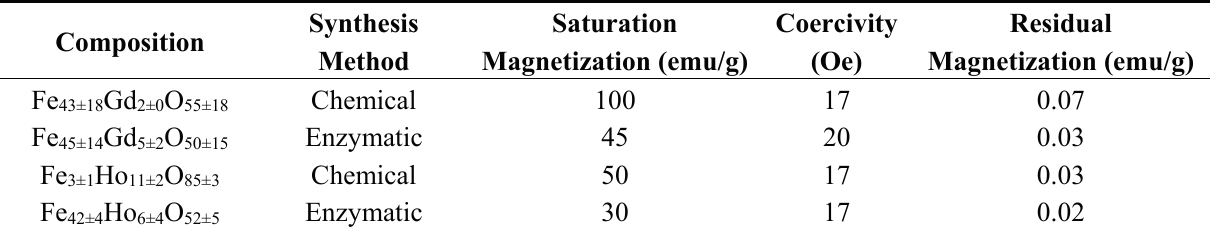
Figure 11. Magnetization curves recorded at 5 K for ( a ) the chemically-synthesized Fe 43±18 Gd 2±0 O 55±18 MNPs and the enzymatically-synthesized Fe 45±14 Gd 5±2 O 50±15 MNPs and ( b ) the chemically-synthesized Fe 3±1 Ho 11±2 O 85±3 MNPs and the enzymatically-synthesized Fe 42±4 Ho 6±4 O 52±5 MNPs. Table 1. Summary of magnetic properties at 5